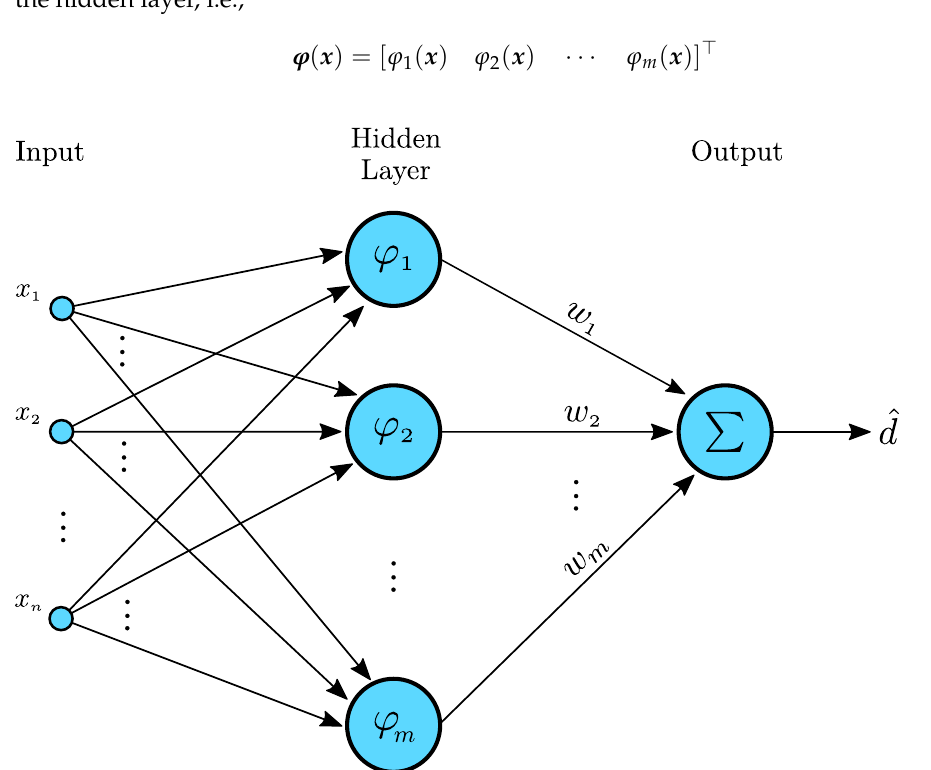
Figure 1. Architecture of a RBF neural network.